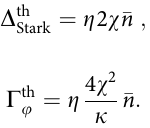
traces (Fig. 5e) feature exponential decay rates G 2E ¼ 1/ T 2E , indicating little (if any) impact from 1/ f noise (charge, flux and so on) and consistent with photon shot noise featuring a short correlation time 1/ k oo T 2E . The extracted pure dephasing rate G (Fig. 5f). The extracted slope agrees with equation (5) to within 5%. The non-zero dephasing rate at (cid:2) n (cid:2) n : 006, add ¼ 0 corresponds to a residual photon population 0 ¼ 0 equivalent to an effective temperature T eff ¼ 80 mK. By compar- ison, the qubit effective temperature determined from its first excited-state population is 35 mK (ref. 13).